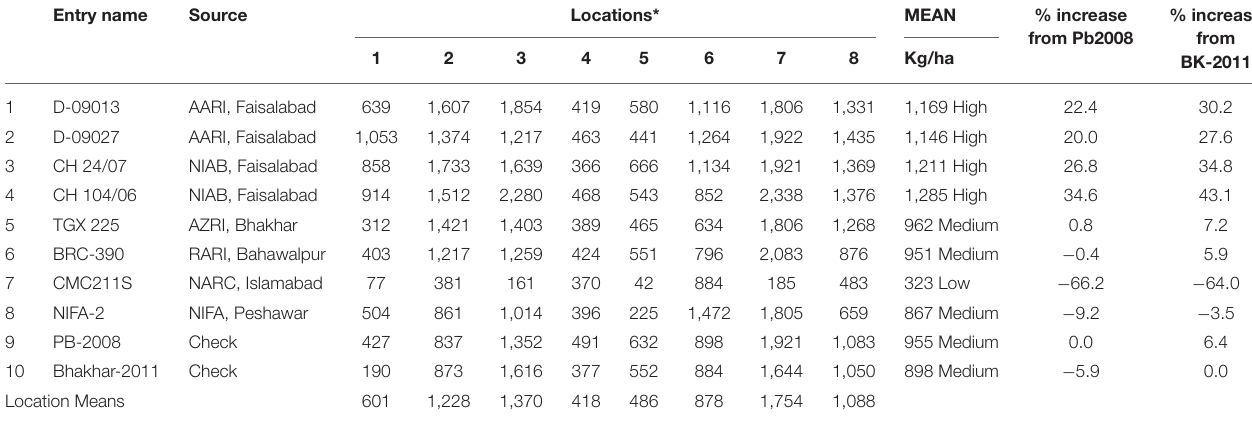
TABLE 2 | Consolidated yield data of Desi chickpea across 8 locations.